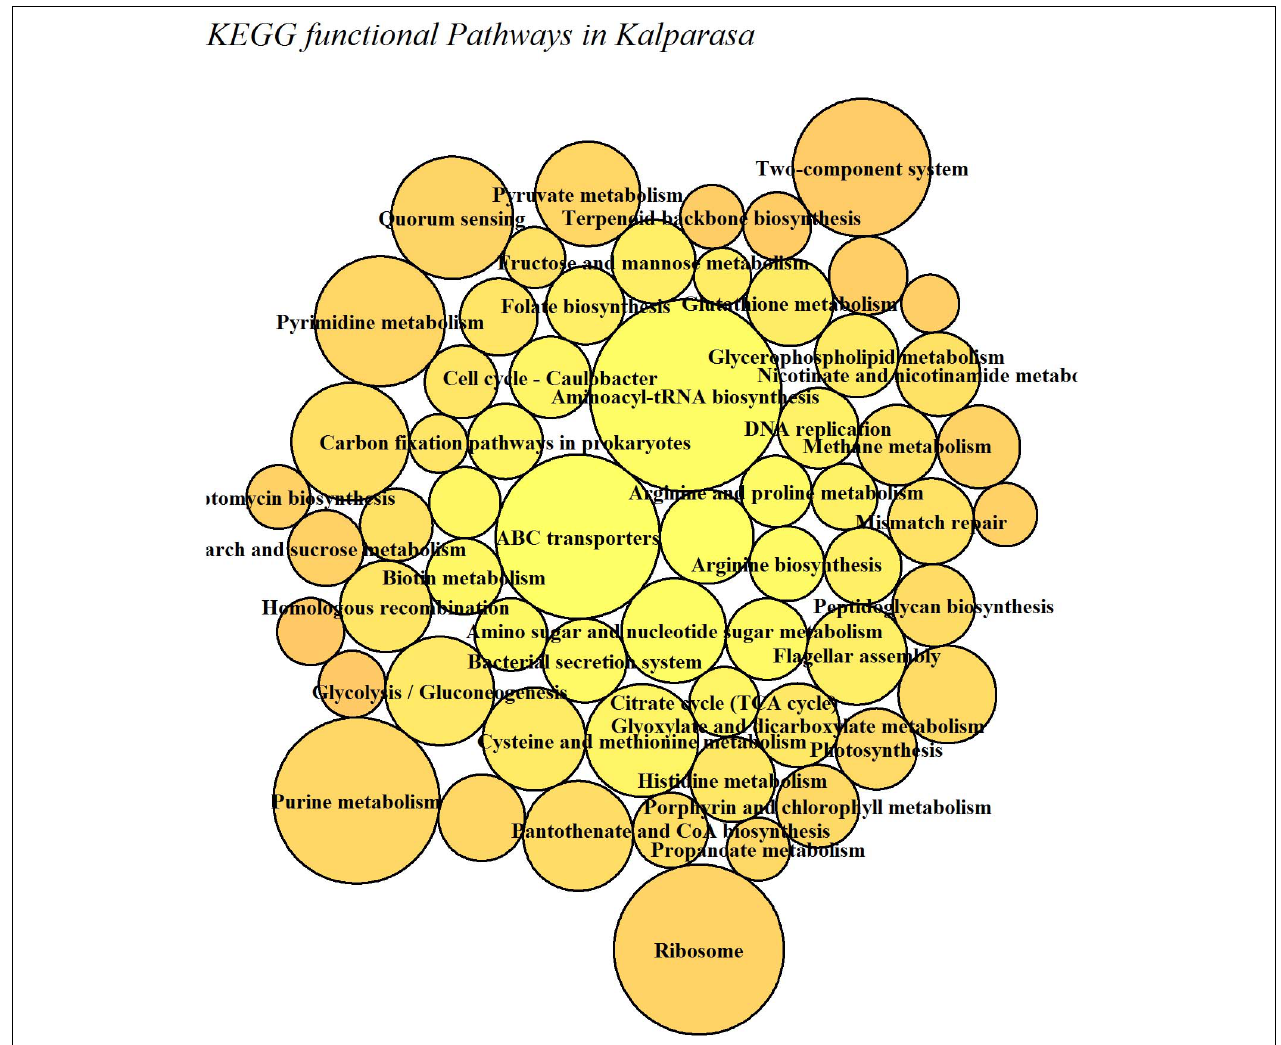
FIGURE 10 | KEGG functional metabolic pathways involved in fresh (CS-F) and 12-h fermented (CS-12H) Kalparasa